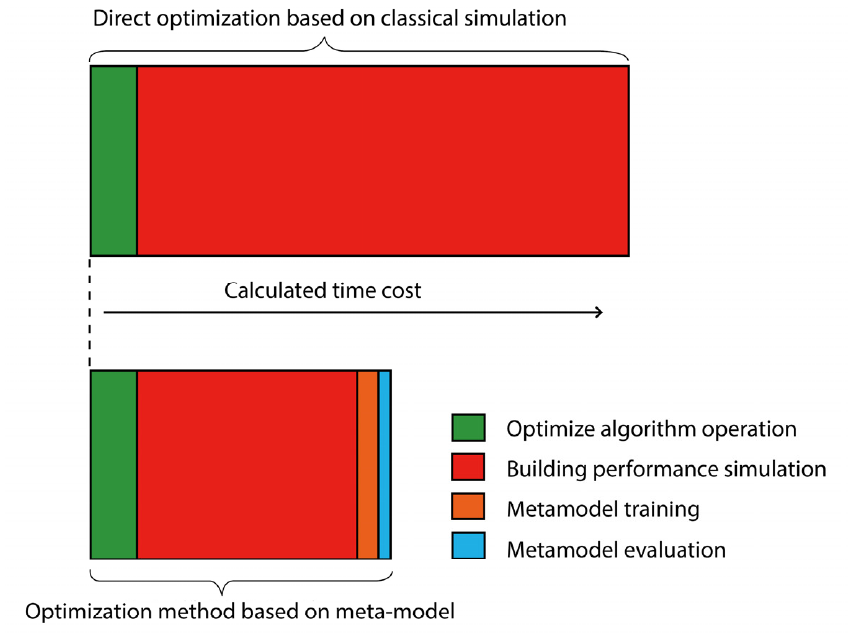
Figure 5. Metamodel-based optimization method and optimization method based on classical